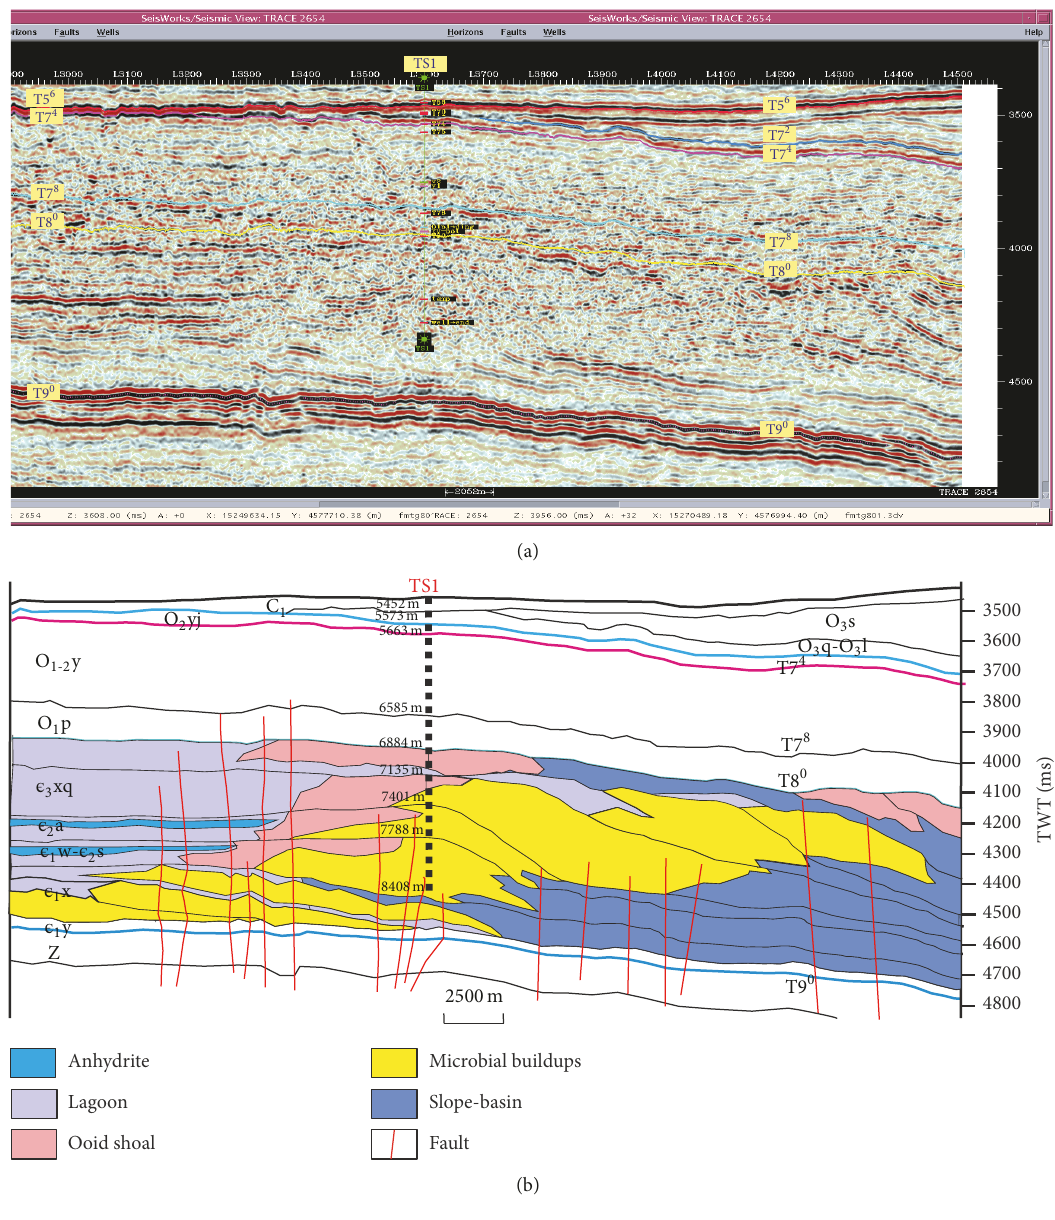
Figure 3: (a) E-W seismic profile across the TS1 (see Figure 1(b) for the location), showing the sequence architecture from the Cambrian to Lower Carboniferous. (b) Interpreted geological profile based on (a), displaying the distribution of lithologies, sequences, and faults. Refer to Figure 2 for the abbreviated symbols of stratigraphic formations. Z-Sinian